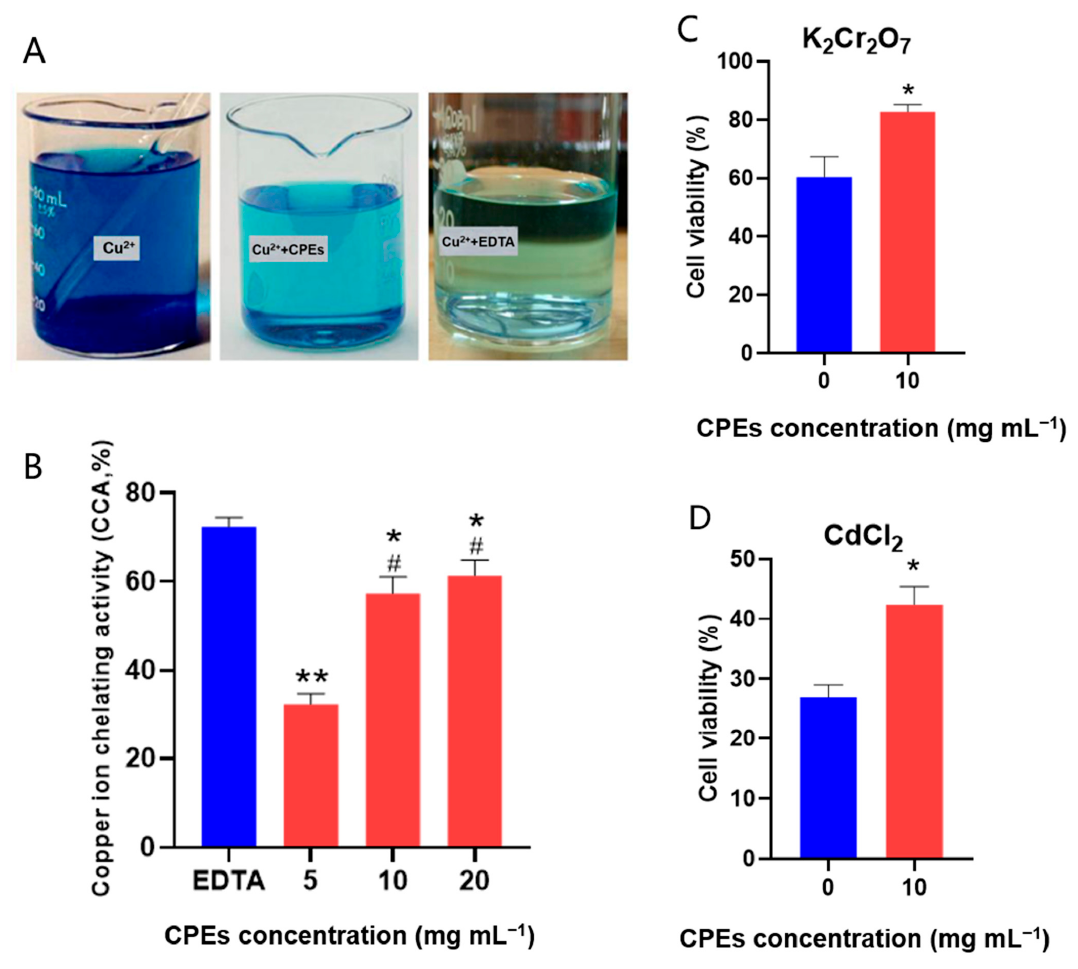
Figure 3. The activity identification of CPEs. ( A , B ) Copper ion chelating activities of the CPEs. Copper ion chelating activity of the CPEs at 5, 10, 20 mg mL − 1 and EDTA at 1 mg mL − 1 were detected at 632 nm. ( C , D ) Chromium ion and cadmium ion chelating activities of the CPEs in HaCaT cell. Cells were administrated with K 2 Cr 2 O 7 (10 µ M) or CdCl 2 (30 µ M) and then added to CPEs (10 mg mL − 1 ) for 24 h, and cell viability was tested by MTT assay. All results are expressed as mean ± SD of three biological replicates. ( B ) * p < 0.05, ** p < 0.01compared with MT; # p < 0.05 compared with CPEs (5 mg mL − 1 ); ( C , D ) * p < 0.05 compared with CPEs (0 mg mL − 1